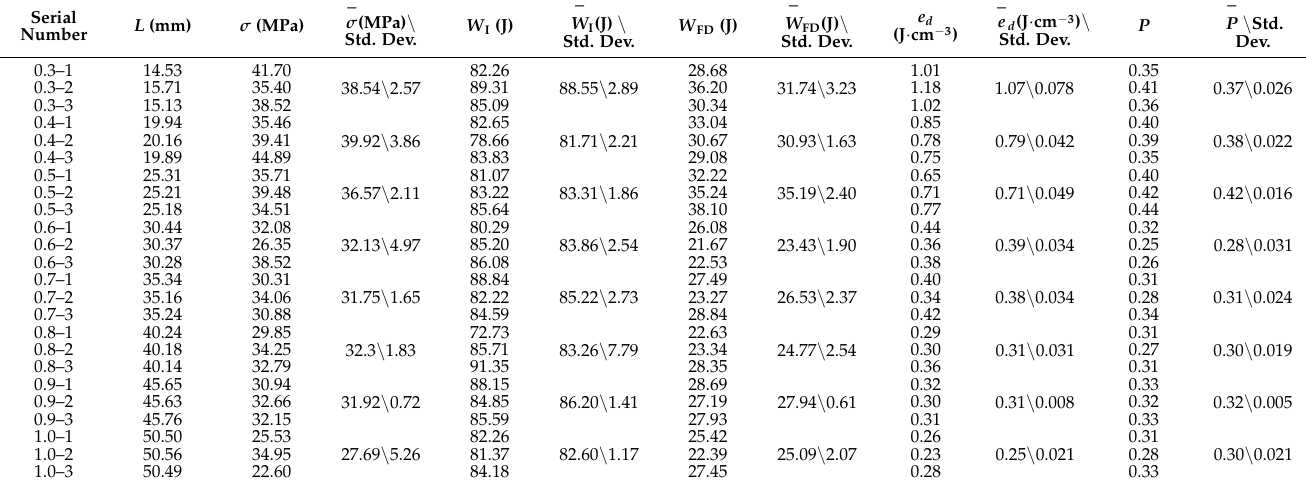
Table 1. Dynamic mechanical properties and energy indexes of samples with different l / d .